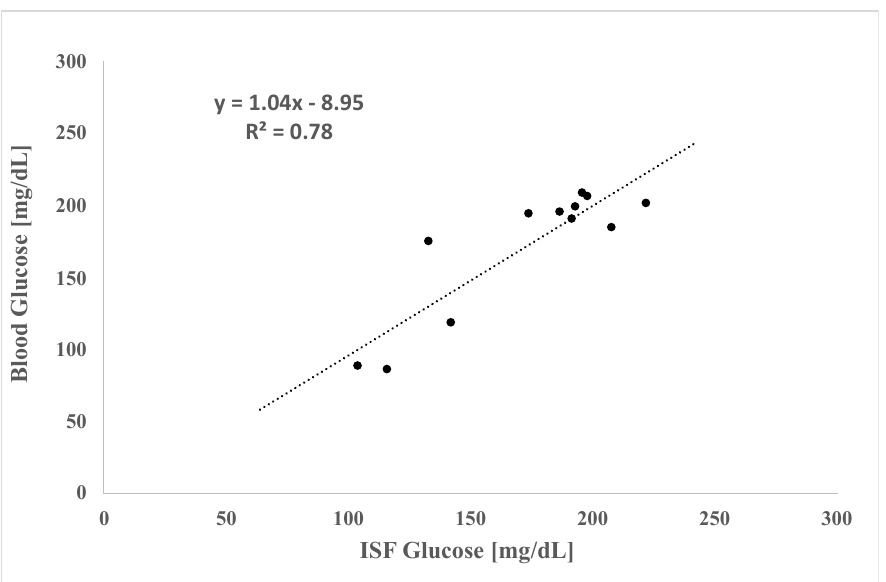
Figure 2. ISF and Blood Glucose Correlations in 17 h Fasted CD Hairless Rats. Number of animals (N) = 2; number of total measurements (n) = 12 for each fluid. Samples were collected over a 1.8 h ISF extraction period while the animals remained under 2% isoflurane anesthesia applied via a nosecone. The dashed line is the linear fit line. The equation and R 2 value are shown in the top left corner of the plot.